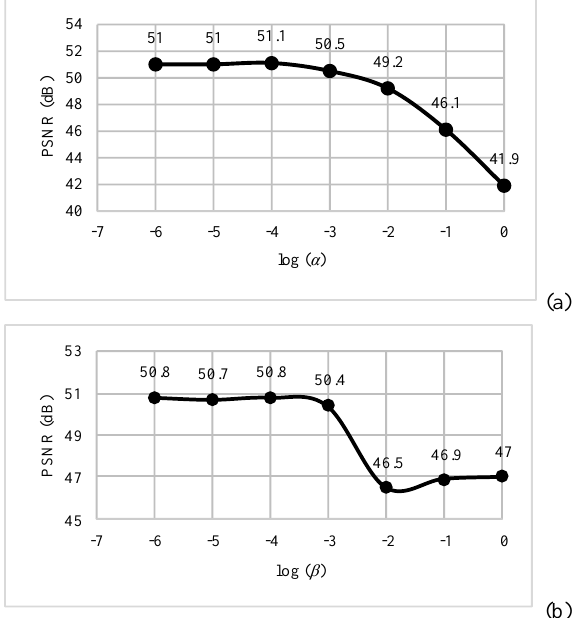
Figure 3 . The effect of the (a) α and (b) β regularization coefficients on PSNR. Due to the small values of α and β , they were represented in the logarithm of 10.